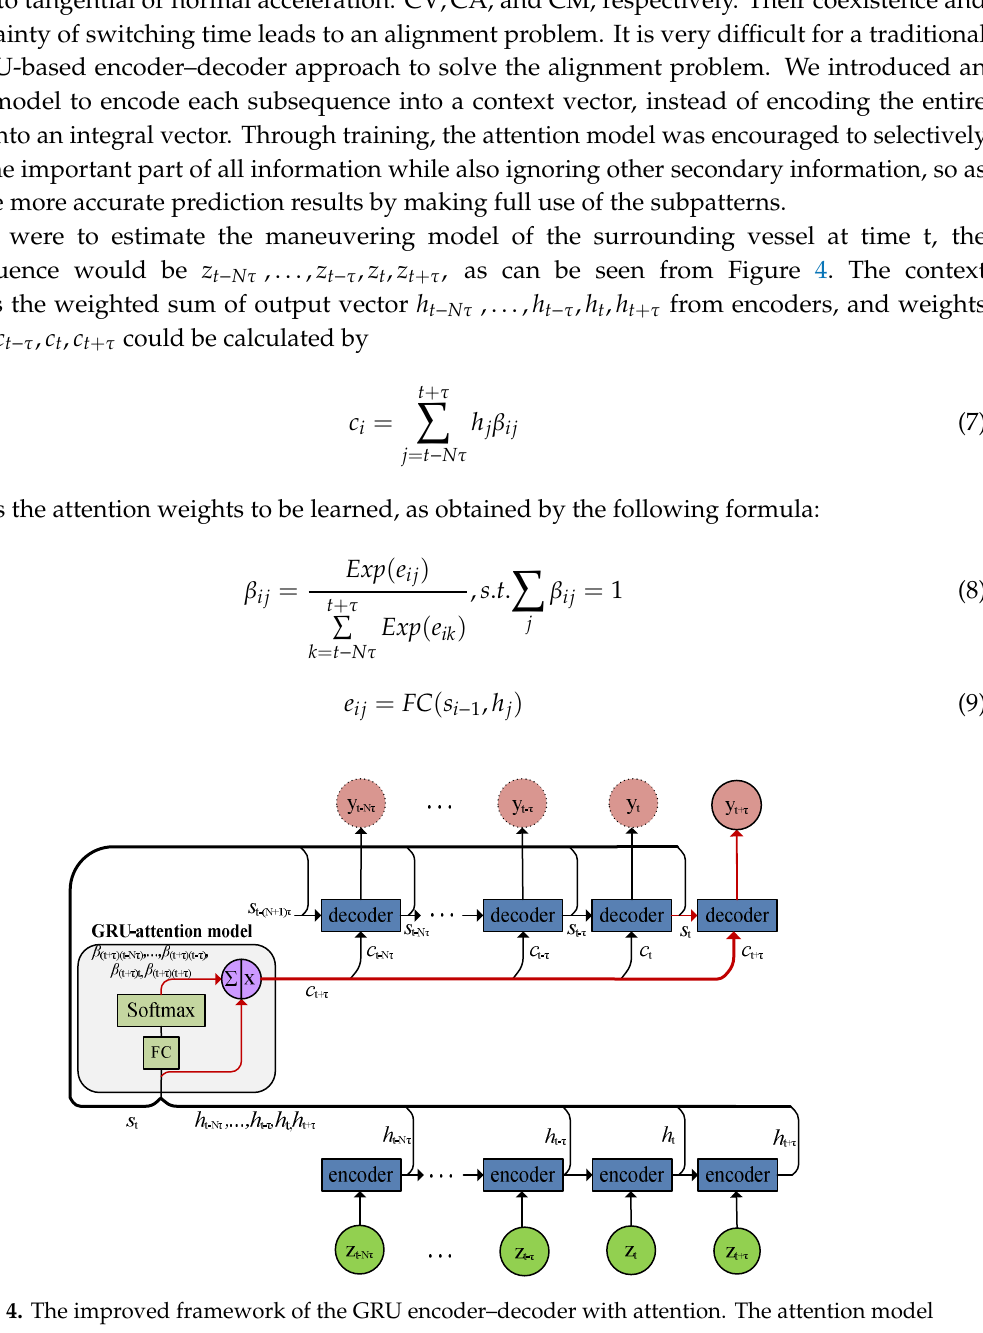
Figure 4. The improved framework of the GRU encoder–decoder with attention. The attention model was embedded between encoders and decoders and learned the attention weights c t − N τ , ... , c t − τ , c t , c t + τ via the fully-connected network (FC) and softmax with loss function, output vector of encoder h t − N τ , ... , h t − τ , h t , h t + τ , and state vector of decoder s t − ( N + 1 ) τ , s t − N τ , ... , s t − τ , s t as the attention model’s input sequence.